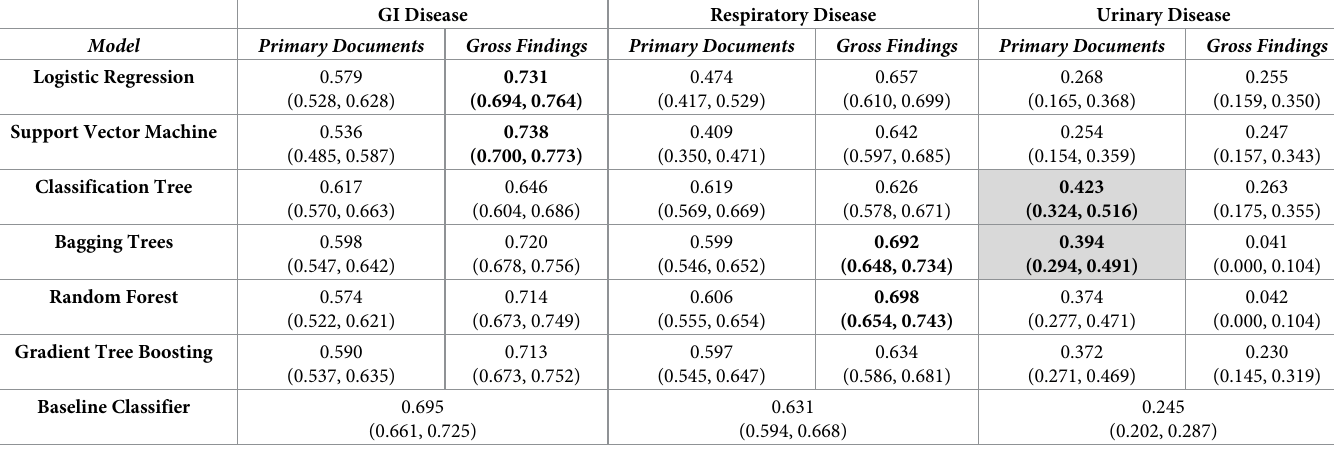
Table 5. F1 Scores for models trained on primary documents or gross findings and tested on gross